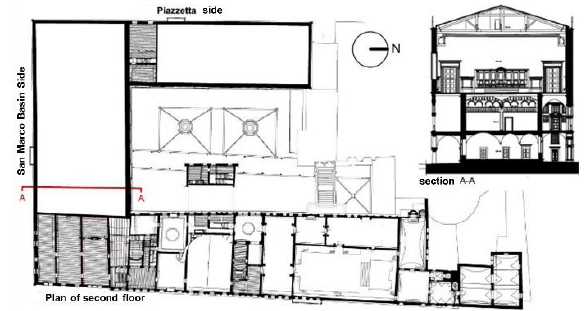
Figure 2. Plan view of the ground level and section view of southern façade of Palazzo Ducale